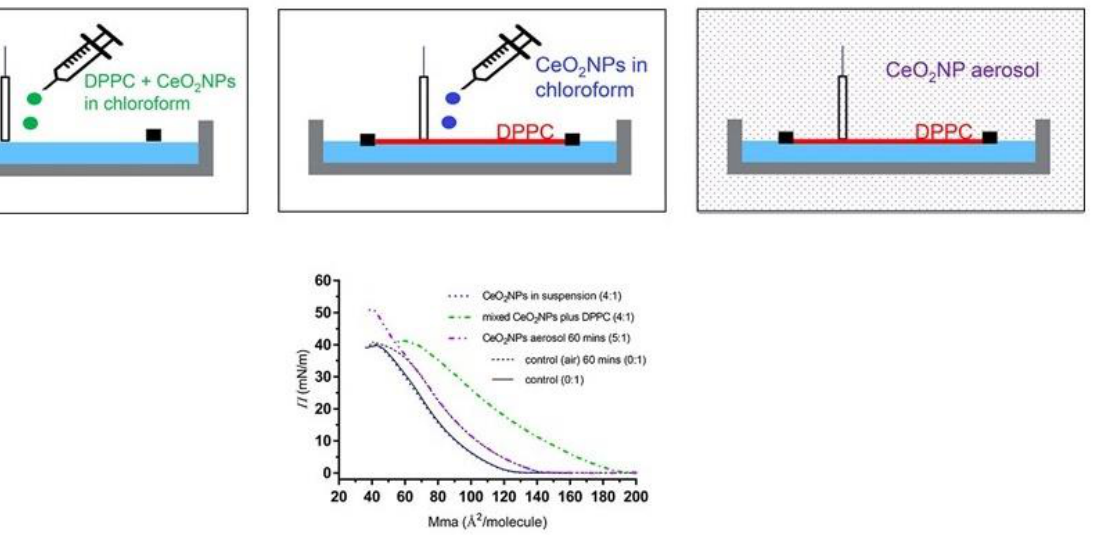
Figure 6. Sketches representing the three different approaches used for incorporating particles into LS models layers based on DPPC, and the differences in the surface pressure-area per molecule isotherm obtained depending on the procedure used for preparing the mixed layers. Adapted from Miguel-Diez et al. [206] , with permission from Elsevier, Copyright 2019.